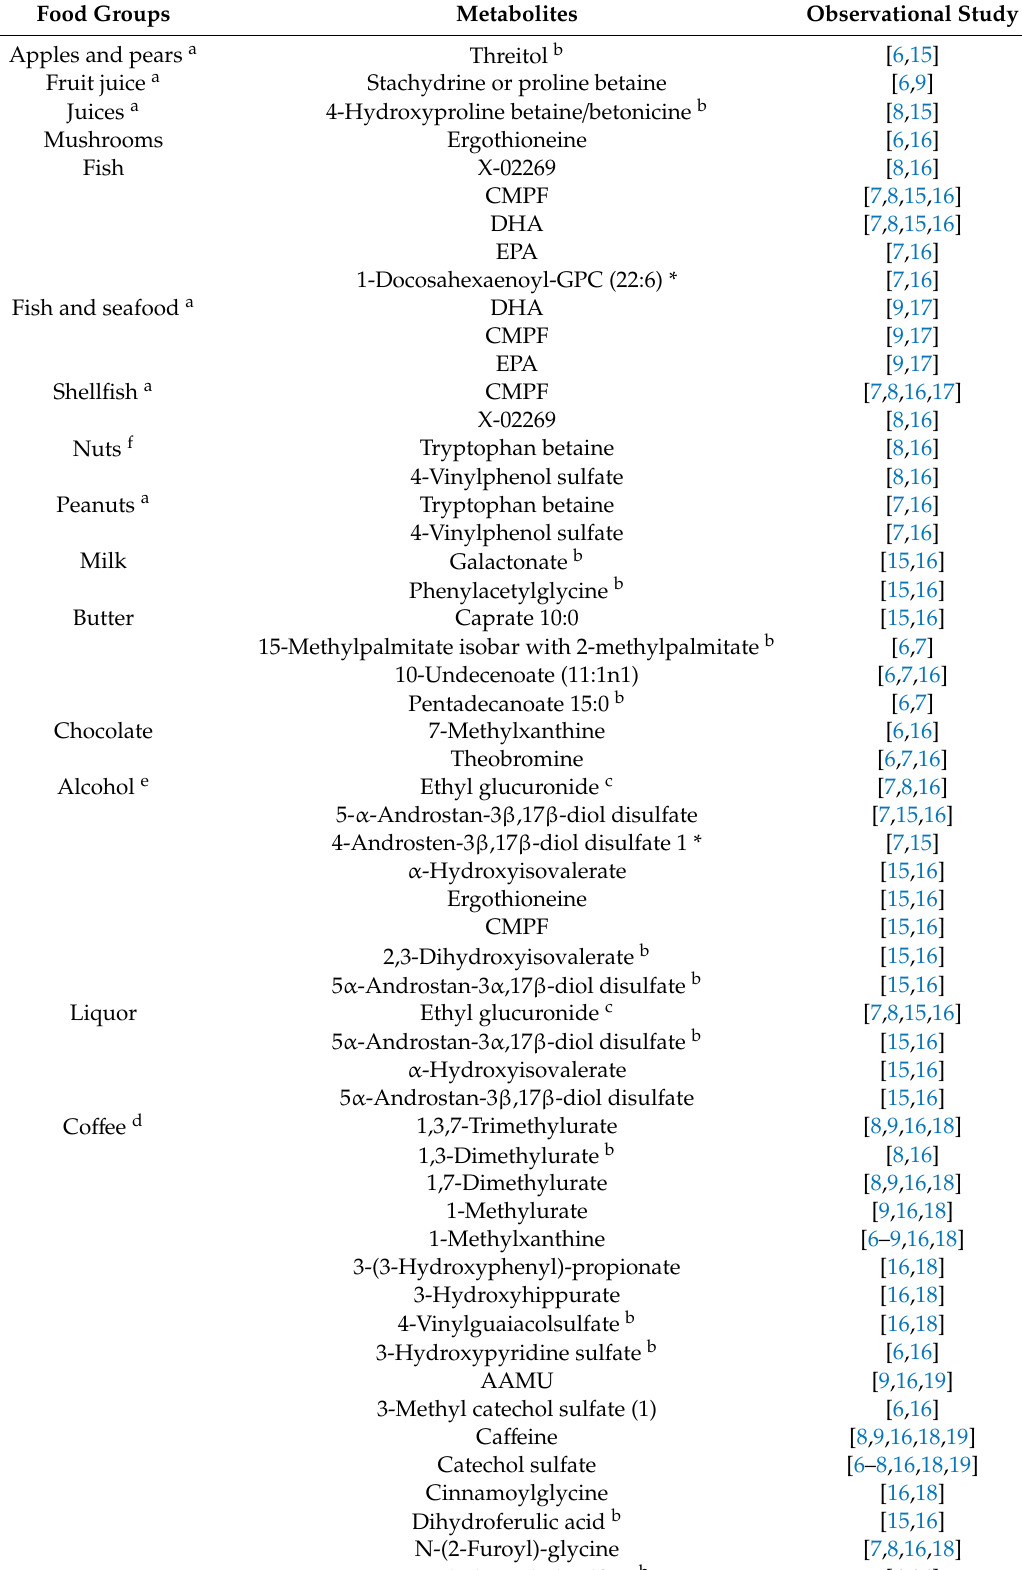
Table 2. Food groups associated with metabolites in at least two independent observational studies (table includes search results up to 16 December